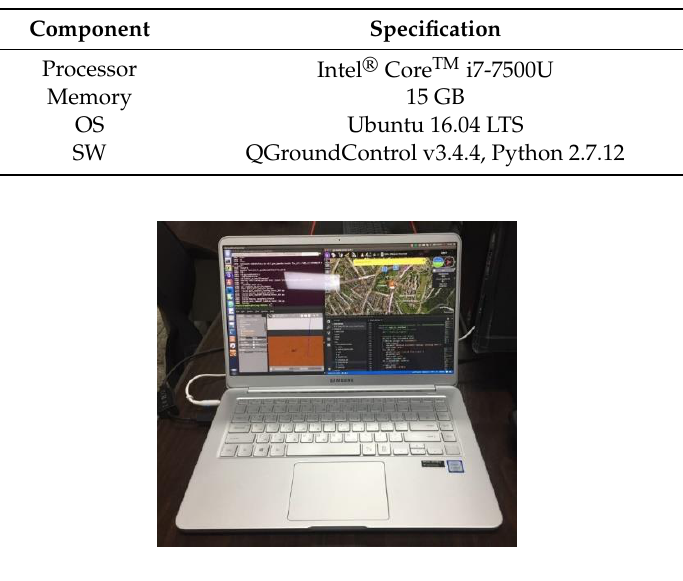
Figure 7. Overview of the UAV.